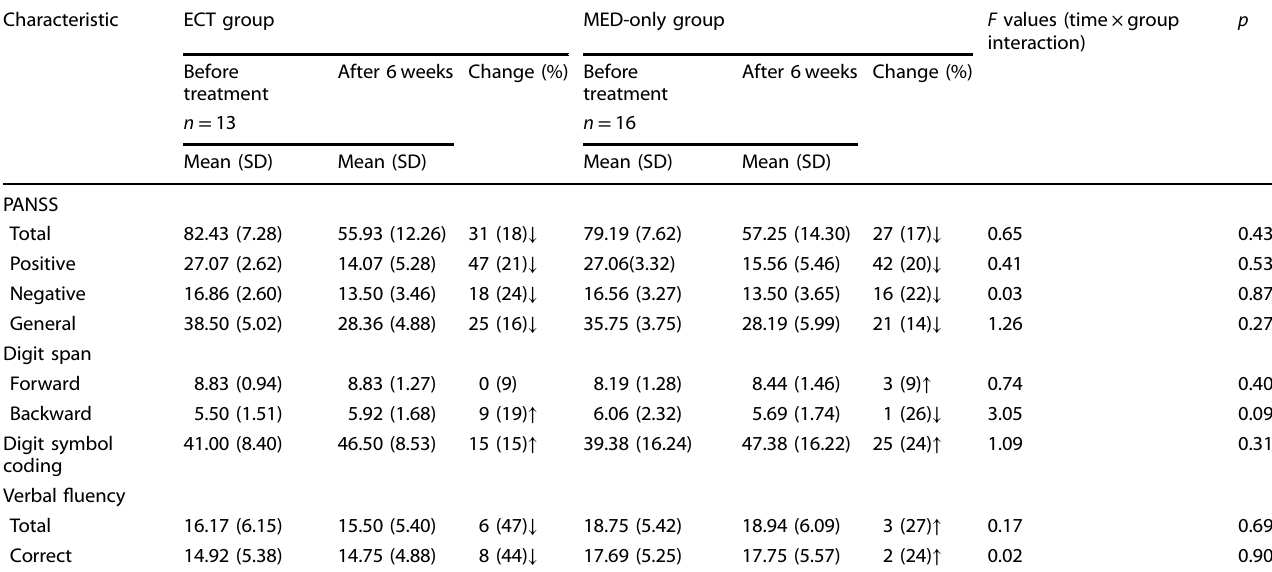
Table 2. Clinical symptoms in patients with schizophrenia before and after 6 weeks of ECT or treatment with antipsychotic medication only Characteristic ECT group MED-only group p Before After 6 weeks Change (%) Before treatment